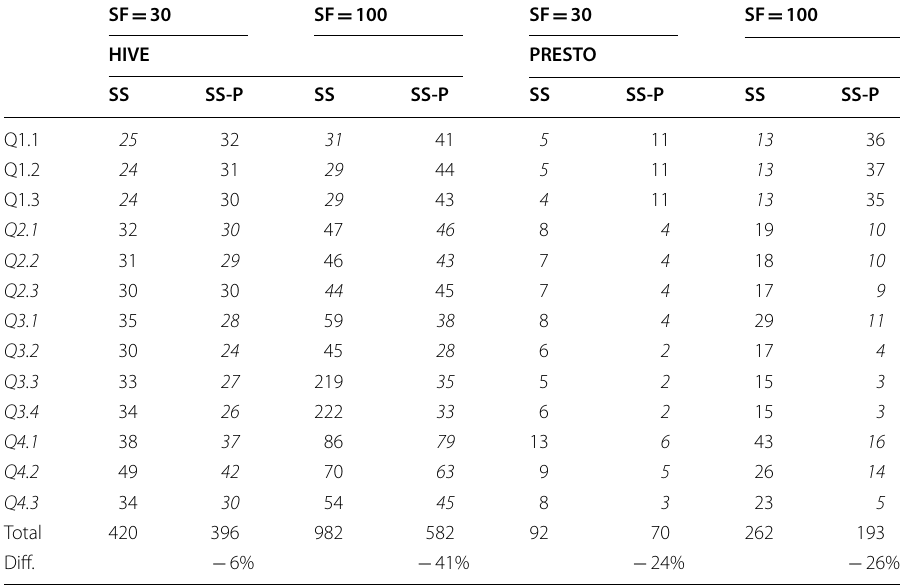
Table 2 SSB execution times (in seconds): partitioning by “S_Region”, “S_Nation” and “S_